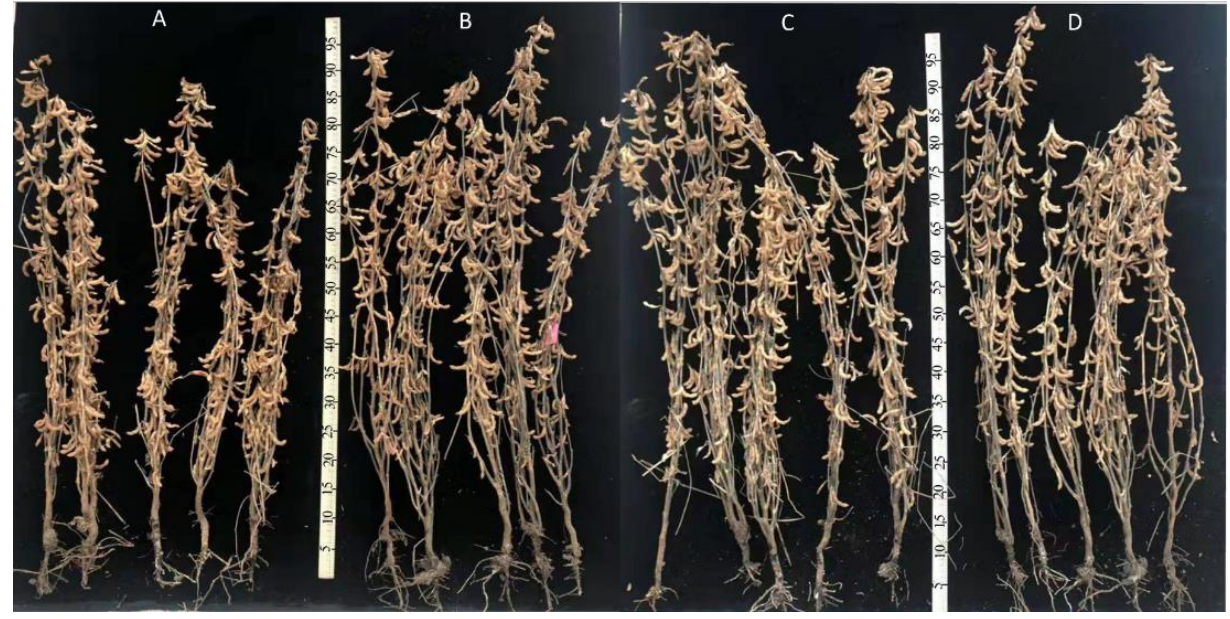
Figure 8. Representative pictures showing plant architecture of the homozygous T 4 generation plants and WT at harvest stage. ( A ) WT plants; ( B ) 3-1 plants; ( C ) 31-1 plants; ( D ) 32-2 plants.